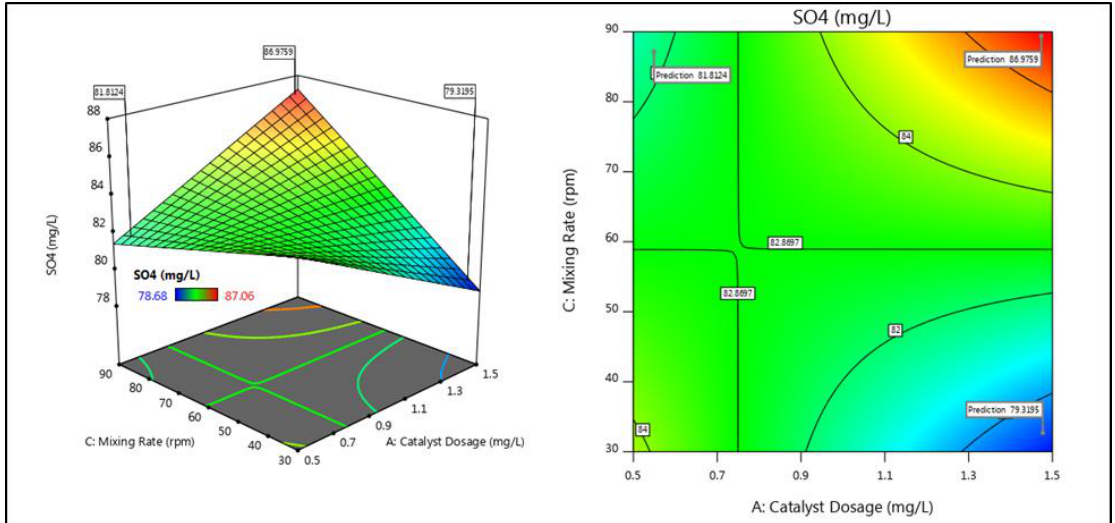
Figure 6. 2D and 3D plots representing the cross factor interactive e ff ects of AC on SO 42 − removal by zeolite.